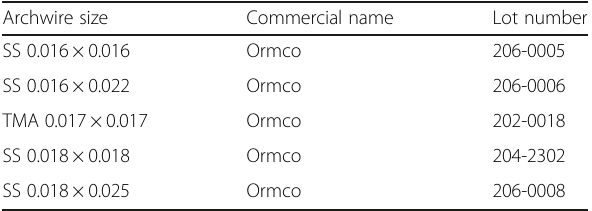
Table 1 Lingual archwires tested in the study cut at their distal straightest portion according to percentage proportion length calculated by virtual set-up Archwire size